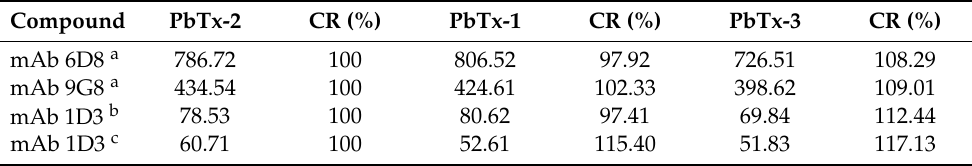
Table 2. IC 50 values ( µ g/kg) and cross-reaction (CR) of monoclonal